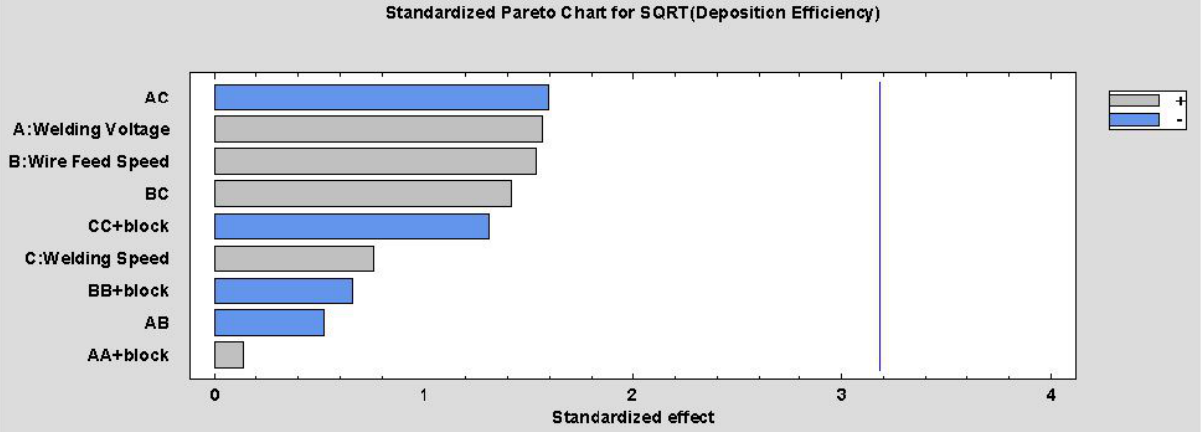
Figure 4. Pareto Chart for SQRT (Deposition Efficiency)